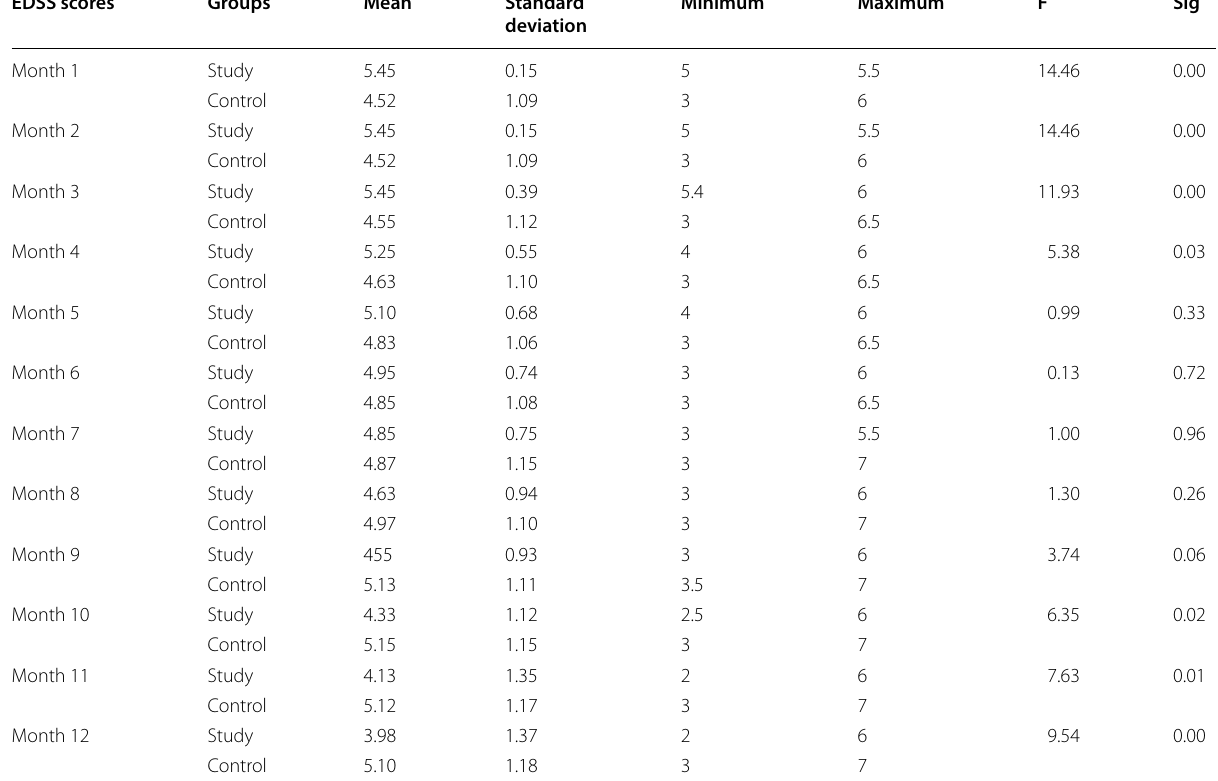
Table 2 EDSS scores in each month during the study period EDSS scores